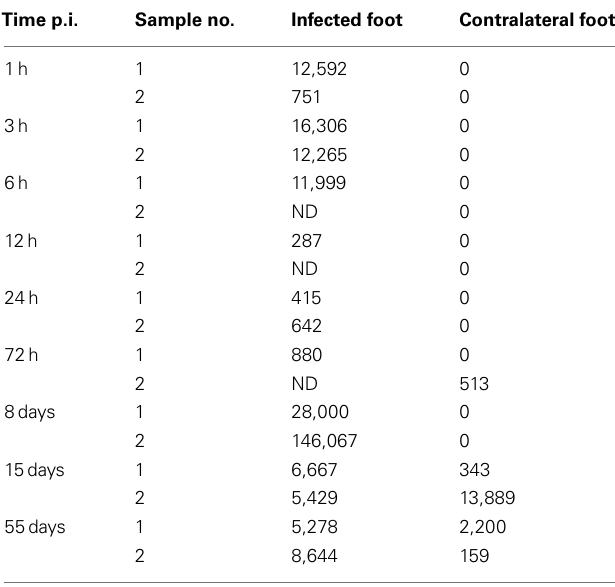
Table 1 | Spirochaete counts per 10 6 mouse tissue cells as determined by qPCR (Pahl et al.,